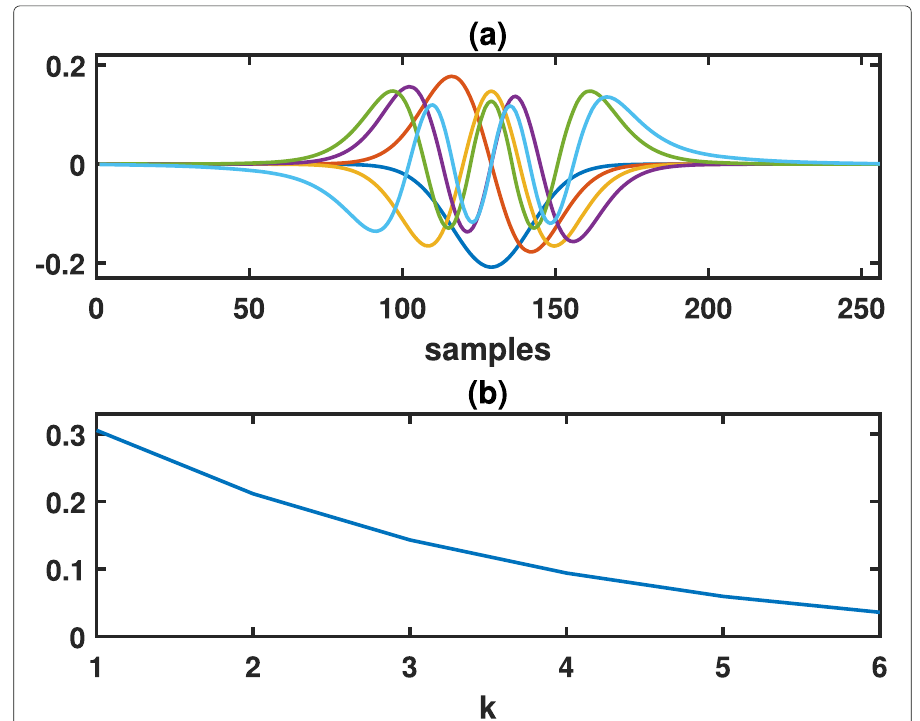
Fig. 3 a MSE optimal multitapers and b weights evaluated for the model parameters ( L , a q , b q , c q , c r ) = (120, 500, 0.20, 800,